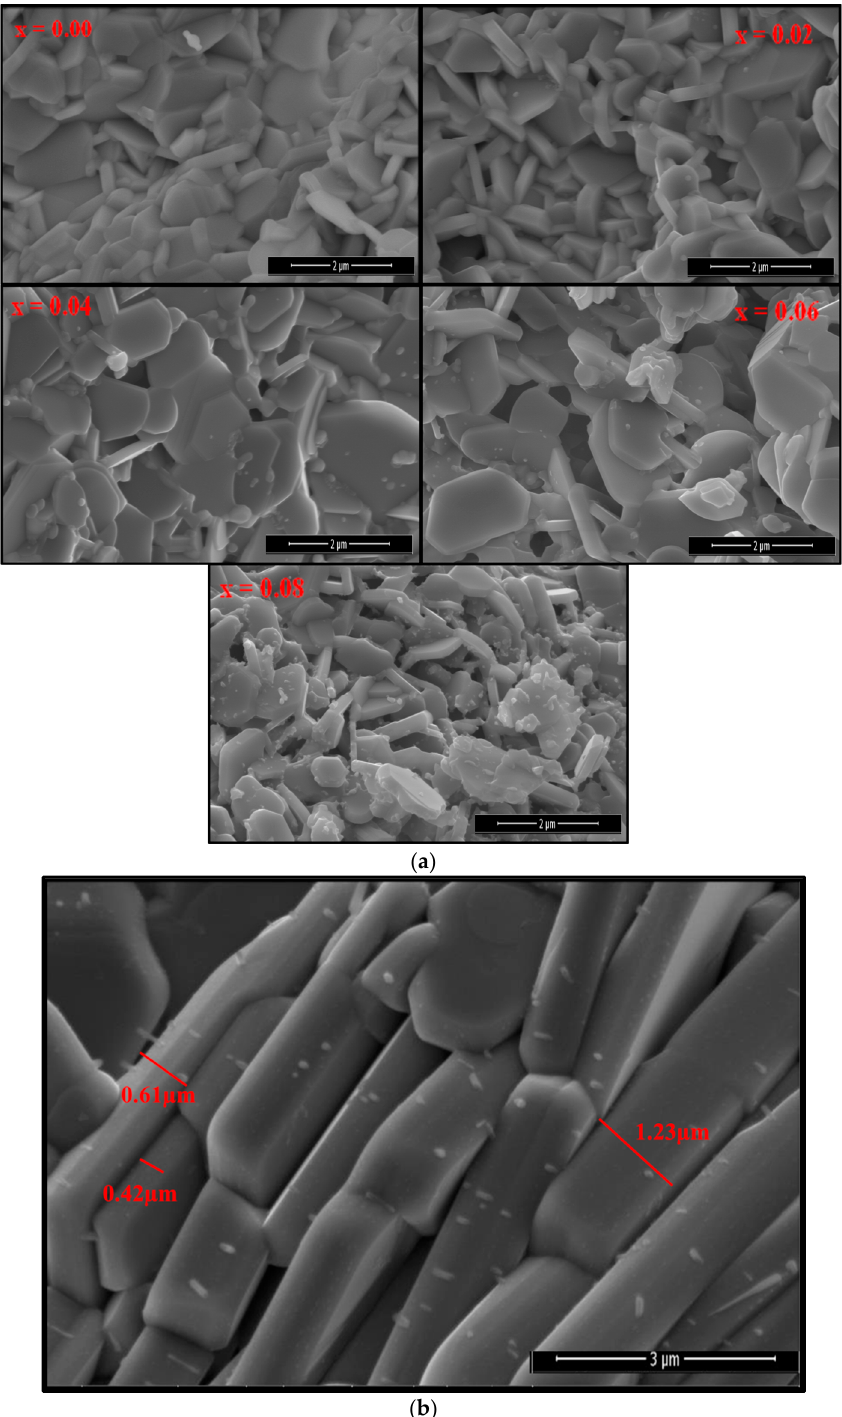
Figure 2. ( a ) FE-SEM micrographs of SrNbxFe12 − xO19 (0.00 ≤ x ≤ 0.08) HFs; ( b ) cross section of SrNbxFe12 − xO19 (0.08) HFs.